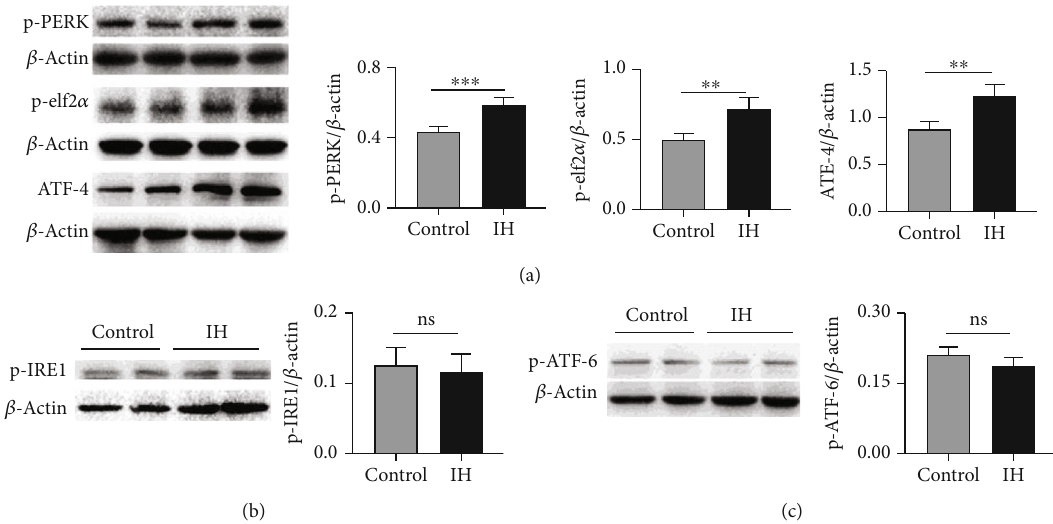
Figure 1: The PERK pathway but not the ATF-6 or IRE-1 pathway was activated. (a) The expression levels of p-PERK, p-elf2 α , and ATF-4 were increased in the hippocampus after 2 weeks of IH exposure ( n = 4 ). The expression of p-IRE1 (b) and p-ATF-6 (c) was not altered ( n = 4 ). ∗ P < 0 : 05 ; ∗∗ P < 0 : 01 ; ns: not signi fi